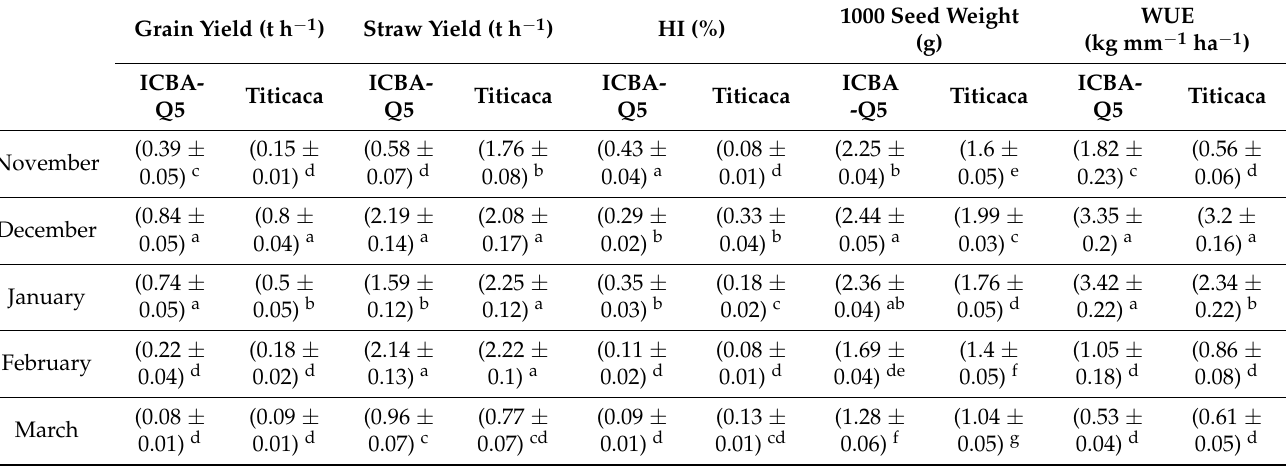
Table 3. Yield components and panicle length of Titicaca and ICBA-Q5 for the different sowing date, Ben Guerir, Morocco (mean ± SD, n = 40).